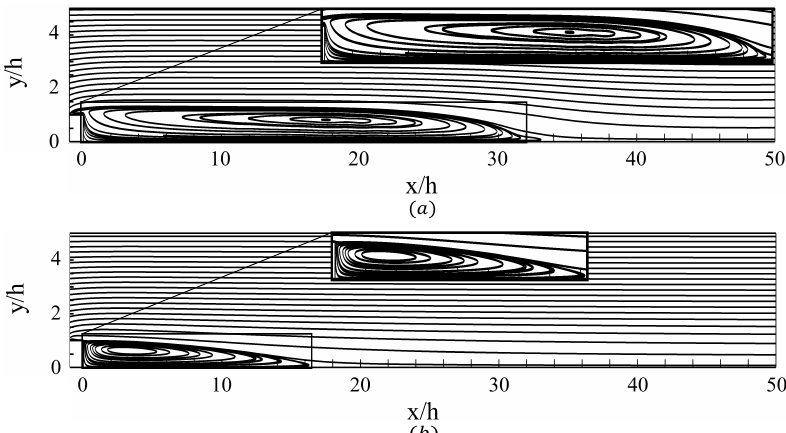
Figure 5. Streamline plot of the ( a ) Newtonian fluid and ( b ) viscoelastic fluid flow past a roughness element of bar height h / D =